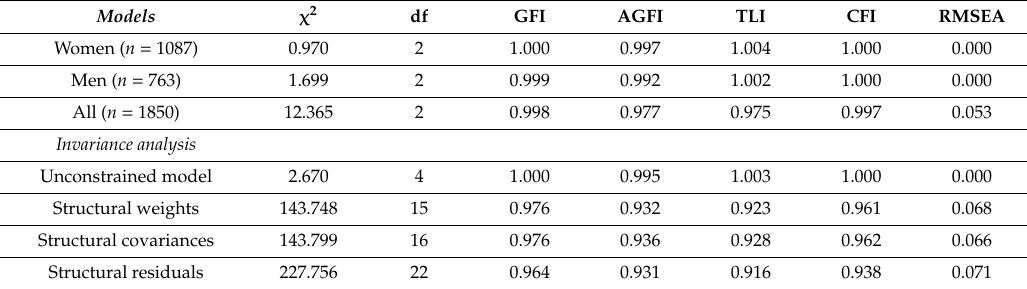
Table 4. Fit of the path models and invariance analysis between genders in a student sample ( n =